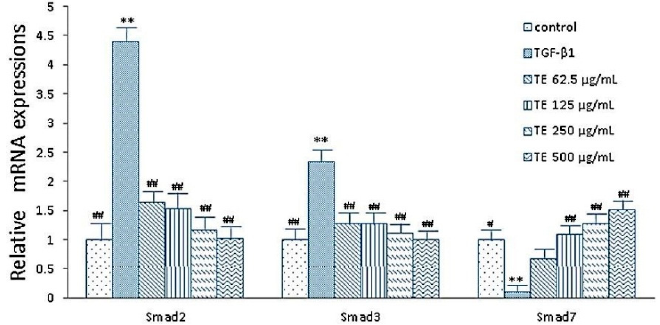
Figure 4. Effects of echinacoside on the expressions of smad2, smad3 and smad7 in HSC (RT-PCR assay). Data were expressed as mean ± SD. ** p < 0.01 compared with control group, # p < 0.05, ## p < 0.01 compared with TGF- β 1 group.